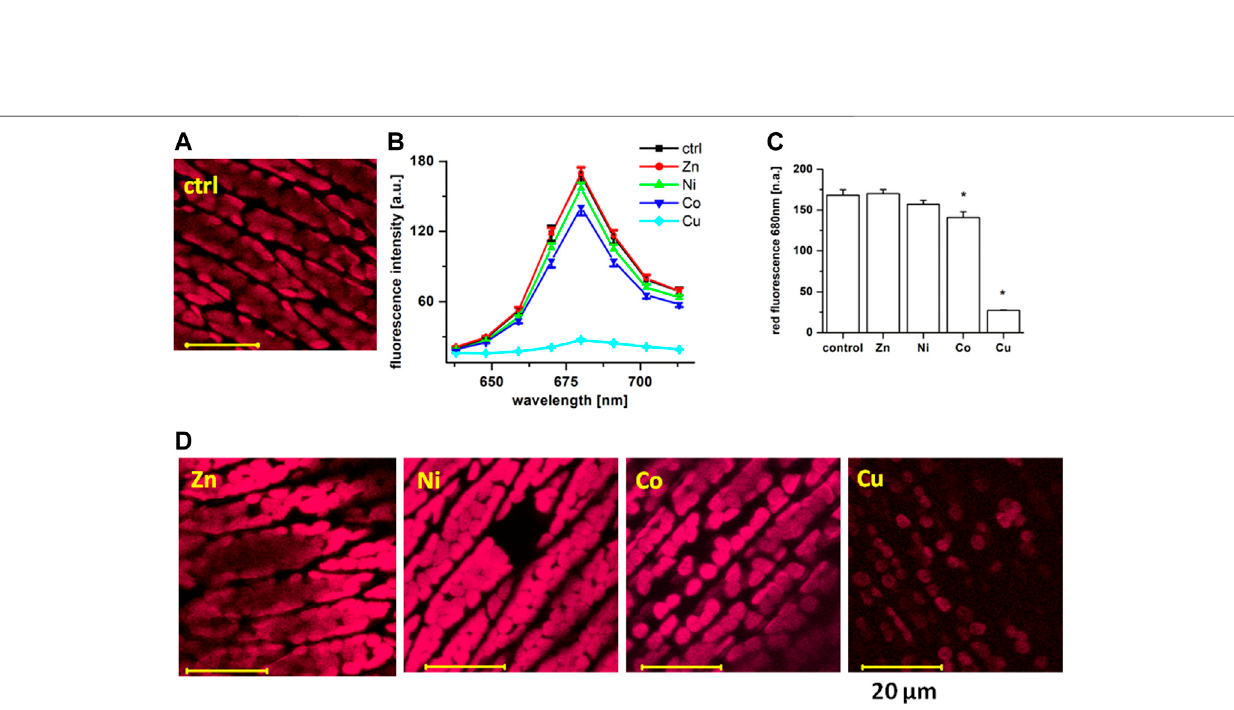
Frontiers in Physics |